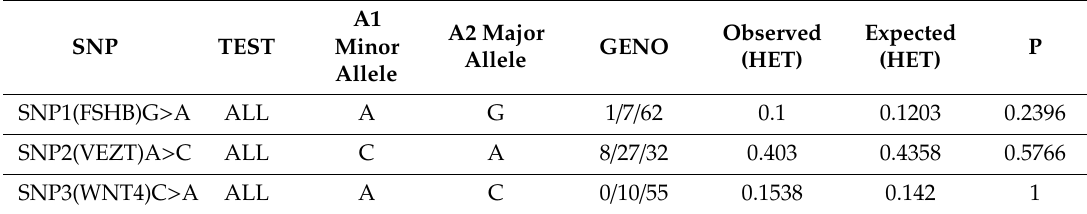
Table 3. Expected and observed frequencies and Hardy–Weinberg equilibrium (HWE) p -values for SNPs investigated in total population.